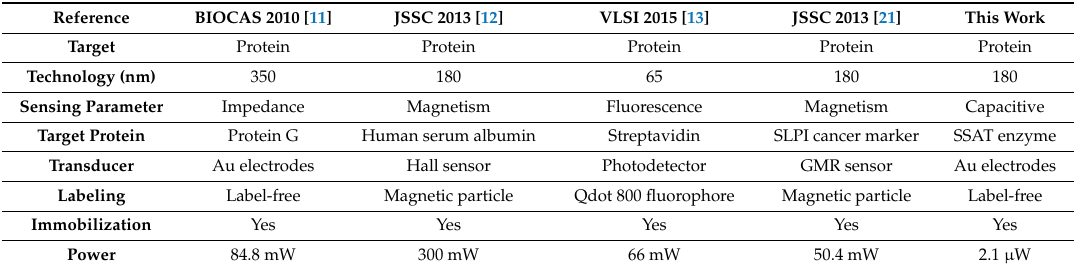
Table 2. Comparison to some of the pre-existing biosensor-CMOS